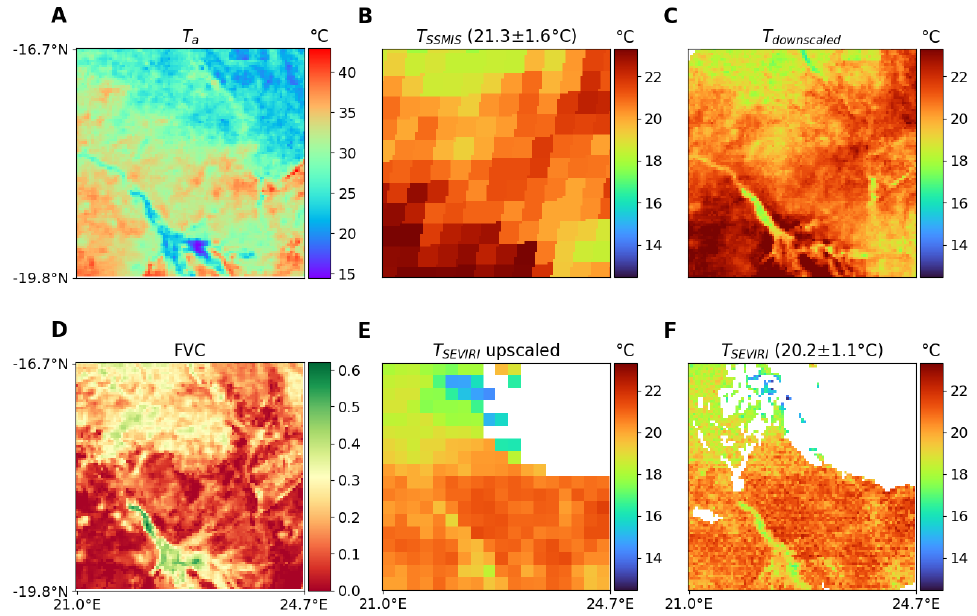
Figure 10. For a scene from the 26th of November 2016 at 05:00 over the Okavango Delta (16.7 ◦ S 21.0 ◦ E to 19.8 ◦ S 24.7 ◦ E): the first column shows 2 of the input ancillary variables: T a ( A ) and FVC ( D ). Panel ( B ) shows the original SSMIS ( T LR ) and panel ( C ) the T downscaled , finally panel ( F ) shows the T SEVIRI at high resolution and panel ( E ) the IR T after a 5 × 5 spatial average. The average temperature and standard deviation for the clear-sky part of the scene are indicated for T SSMIS and T SEVIRI